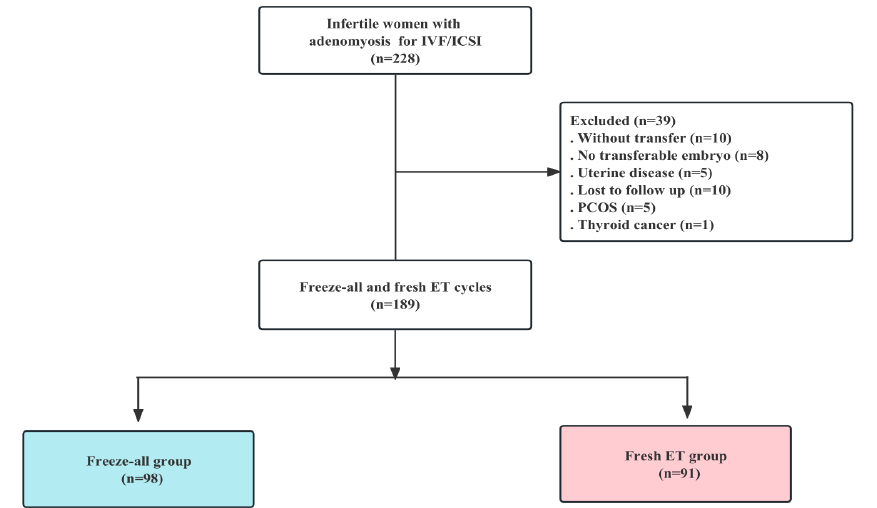
Figure 1. Flow chart of the cohort screening in the study.